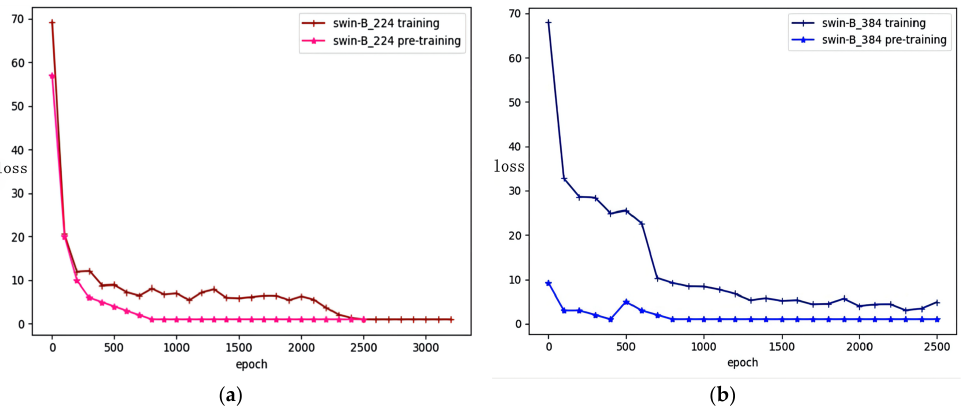
Figure 6. Comparison of loss for Swin-B with different image sizes. ( a ) Comparison of loss for Swin-B with image size of 224 in training and pre-training; ( b ) Comparison of loss for Swin-B with image size of 384 in training and pre-training.